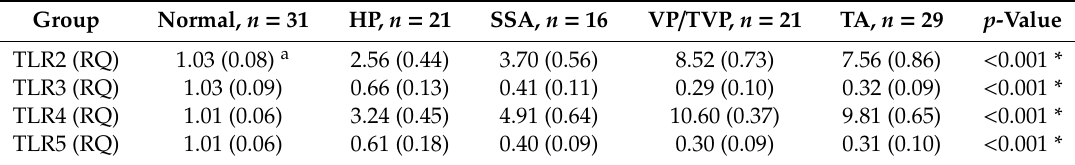
Figure 1. Toll-like receptor (TLR) mRNA expression levels based on relative expression (RQ) in different types of histological polyps: Distribution of TLR2, TLR3, TLR4, and TLR5 mRNA expression levels between normal, hyperplastic (HP), sessile serrated adenoma (SSA), villous/tubulovillous (VP/TVP), and tubular adenoma (TA) polyps in horizontal axis, in vertical axis; ( A ) TLR2 RQ, ( B ) TLR3 RQ, ( C ) TLR4 RQ, and ( D ) TLR5 RQ. Table 2. Expression of candidate TLRs in normal, HP, SSA, VP/TPV, and TA groups.